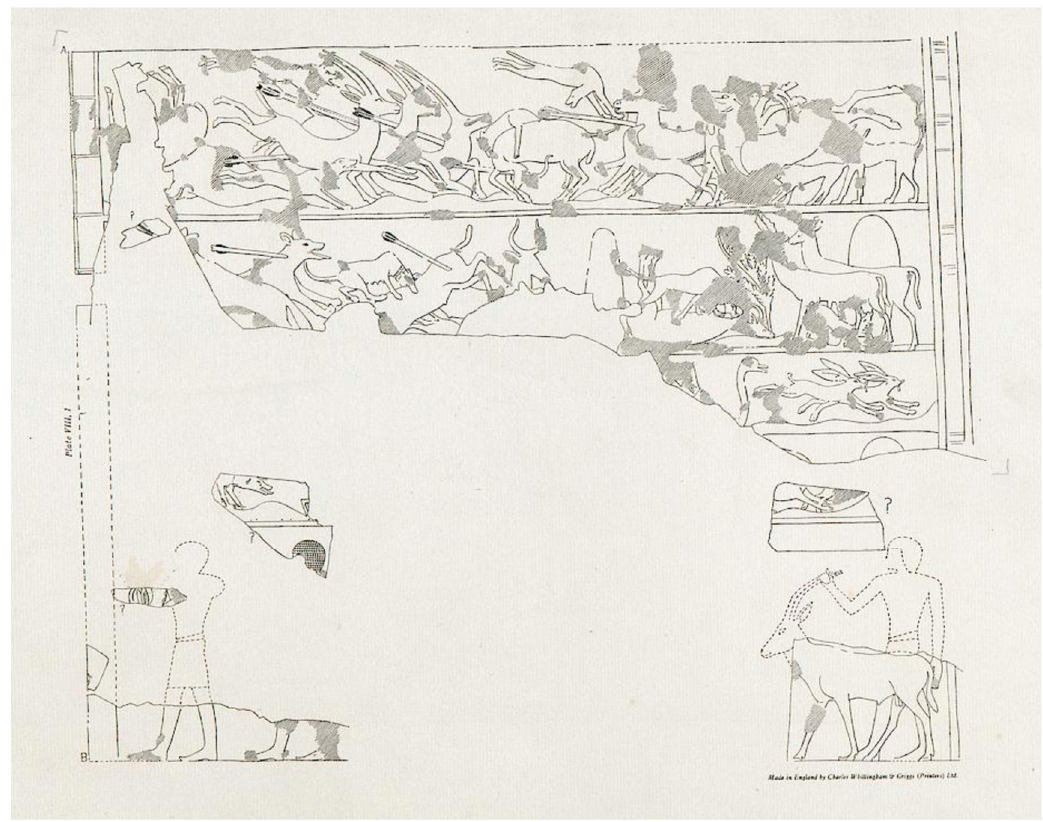
Figure 6. Hunting in the Desert, Tomb of Puyenre (TT39), El-Khokkha, Thebes, 18th Dynasty. (Davies 1922, Pl. 7.).